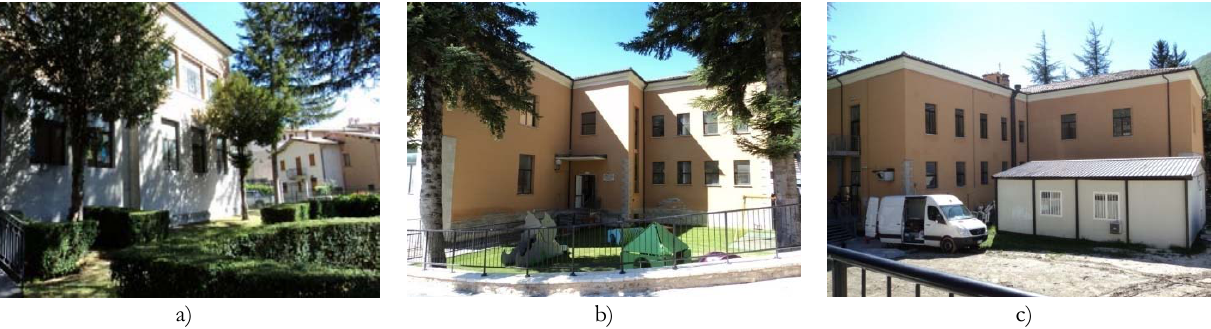
Figure 1: “Pietro Capuzi” school: a) main façade, b) northwest façade, c) northeast façade [6].